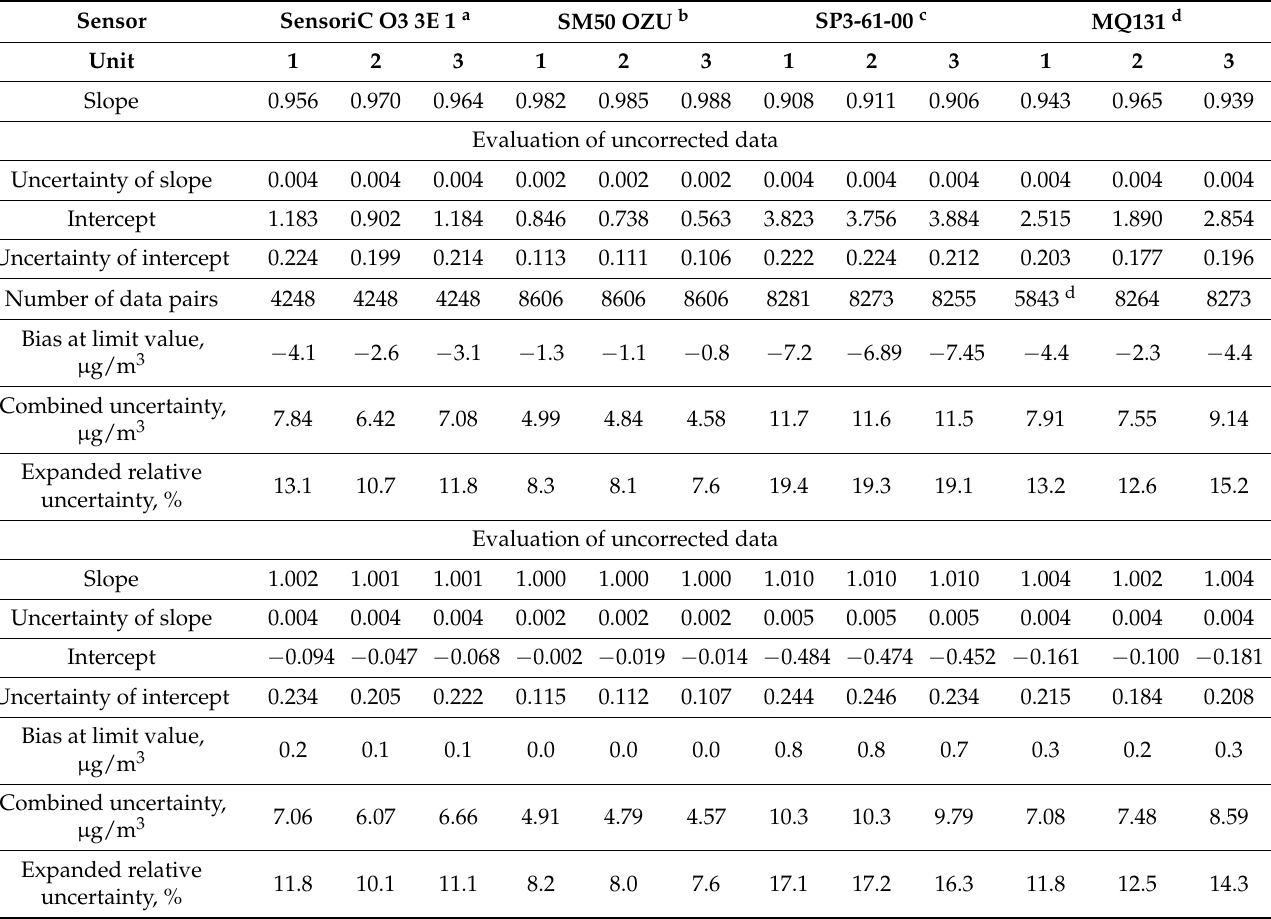
Table 3. Results of the equivalence tests of sensor